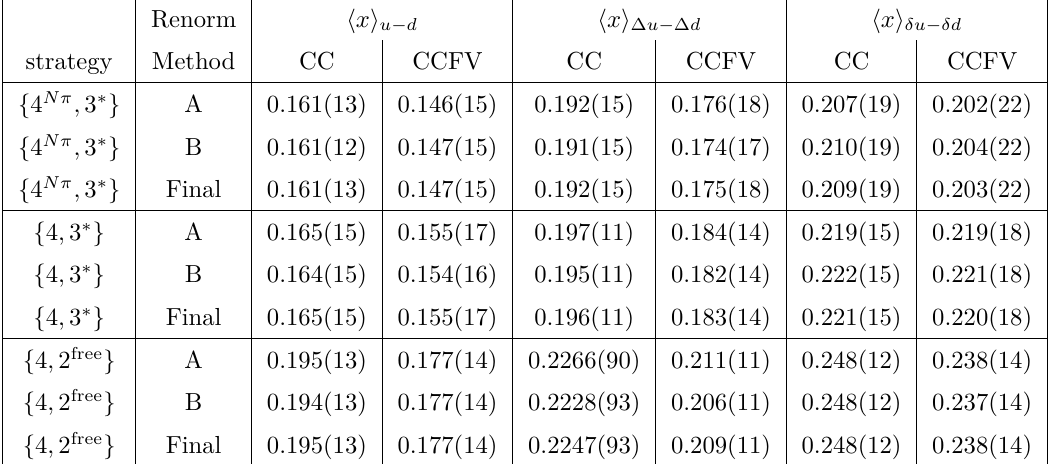
Table 4 . The final results of the chiral-continuum-finite-volume fits for the three moments and the three strategies used to remove excited state contamination. Results are given for the two methods of renormalization (A and B) discussed in appendix C. The final value for each strategy is taken to be the average of the two estimates along with the larger of the two